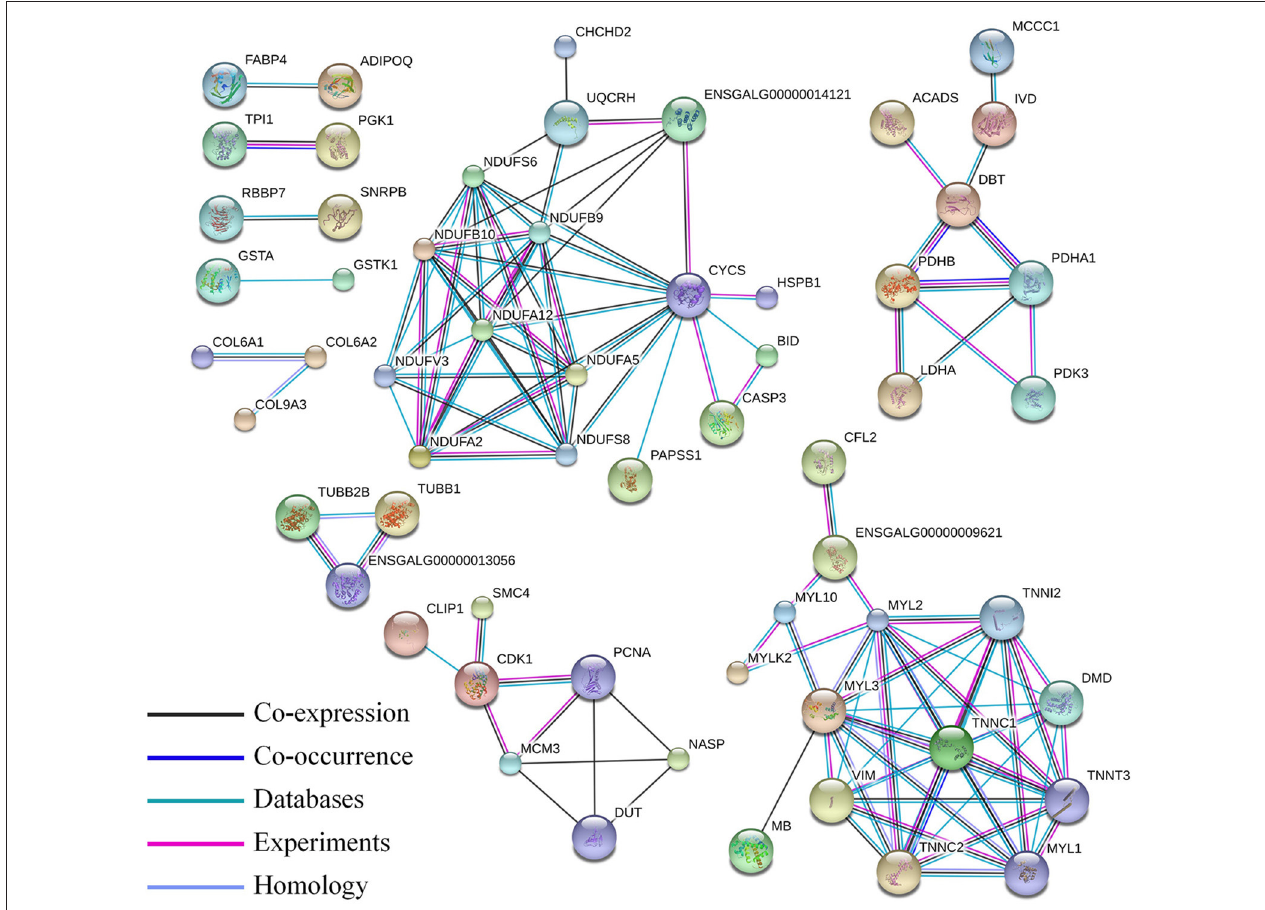
FIGURE 6 | Protein–protein interaction network of the differentially expressed proteins correlated with their mRNA expression level. In this network, nodes represent proteins, and lines with different colors represent the predicted